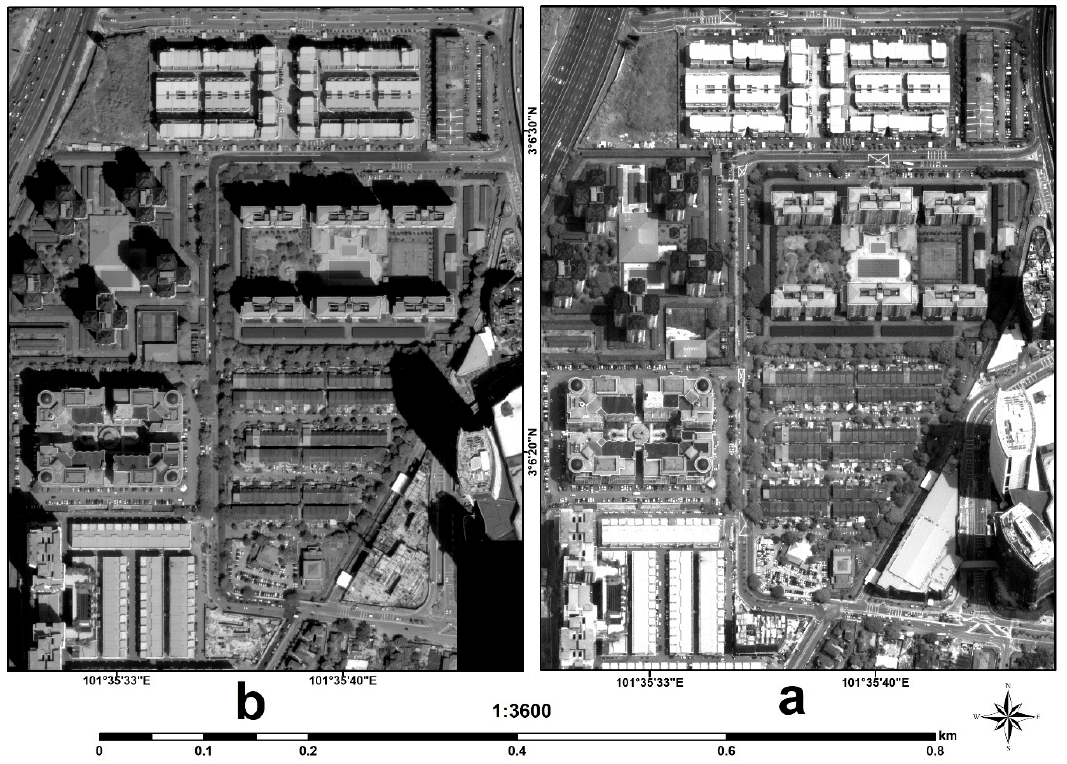
Figure 8. ( a ) Original basic WV-3 PAN band and ( b ) orthorectified image using BI systematic with 80 GCPs.